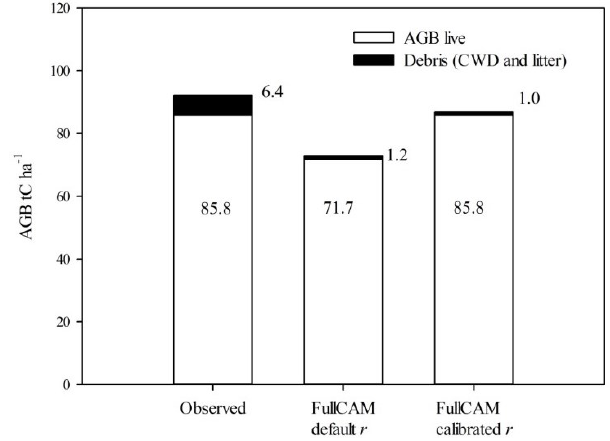
Figure 5. Observed and Full Carbon Accounting Model predicted (before and after calibration) aboveground biomass (AGB) and debris pools (tonnes carbon per